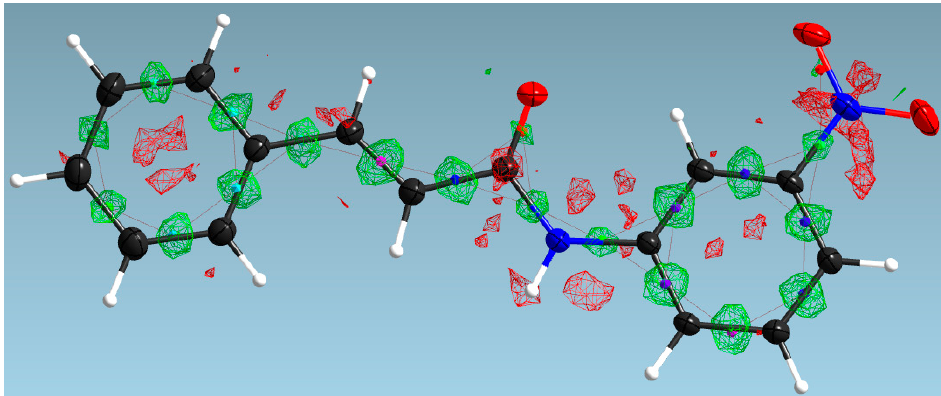
Figure 5. Herringbone arrangement of π -stacked ribbons viewed along the c-axis. Parallel planes defined by molecules shown in transparent beige. Interplanar distances are shown in green (Å).